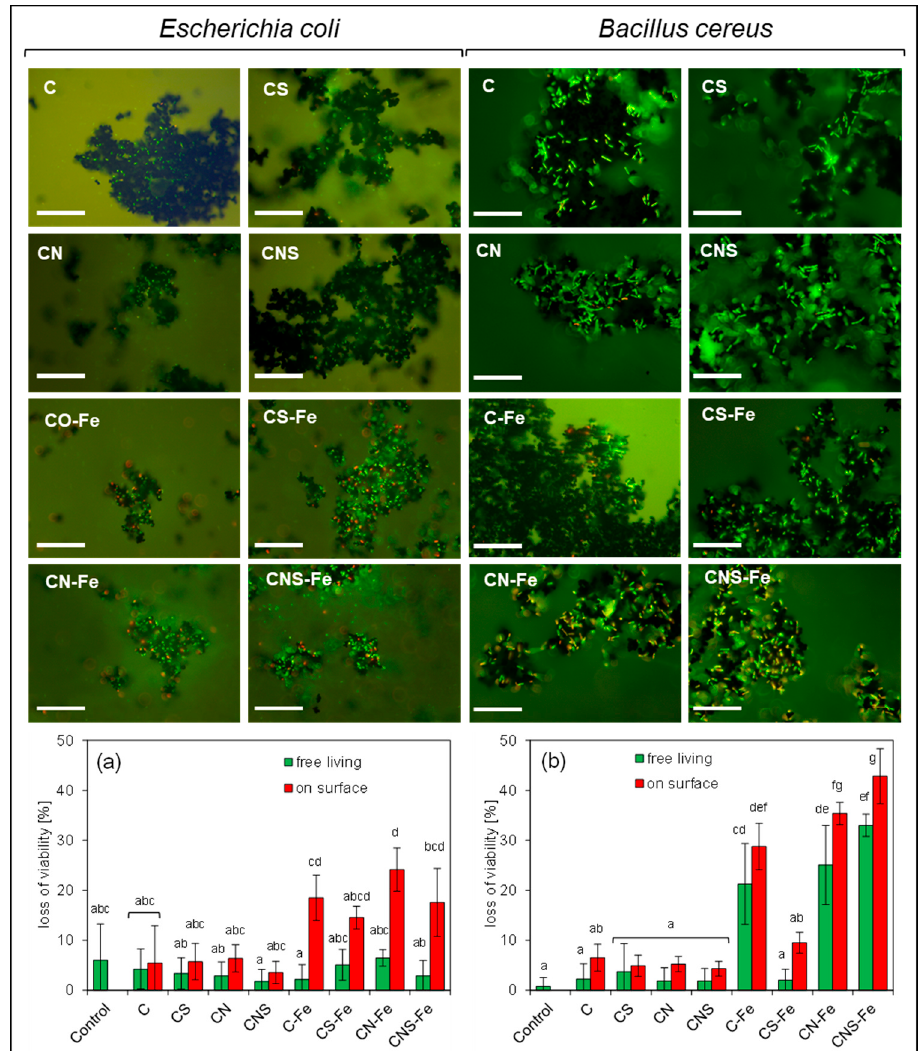
Figure 3. Examples of fluorescent microscope pictures, bar 50 µm. Loss of viability of free living and adsorbed bacteria on the doped carbons, ( a ) E. coli and ( b ) B. cereus . The bars with the same letters do not differ statistically.